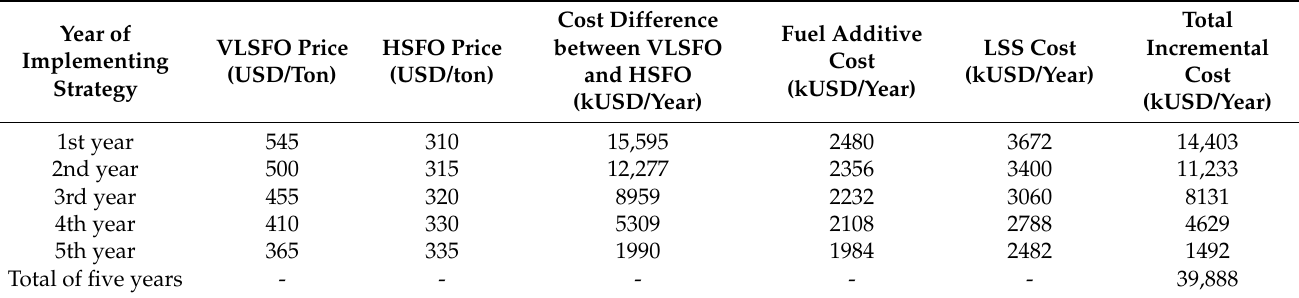
Table 6. Incremental costs of Strategy